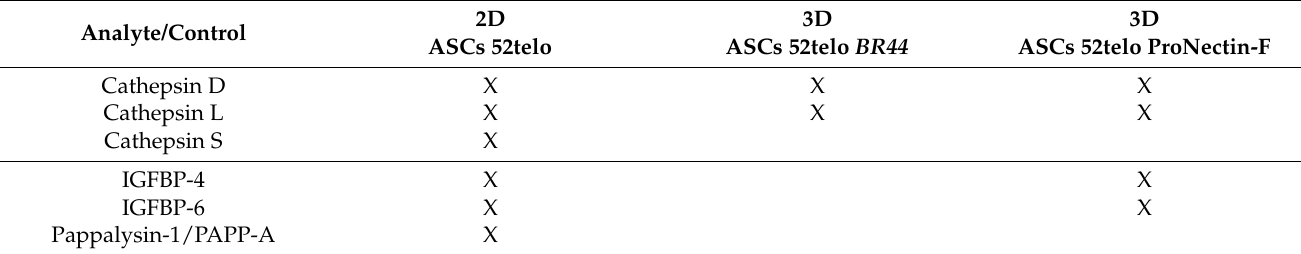
Table 5. Summary of the relevant secreted factors of ASC52telo cells cultured in standard cell culture vessels (2D) or dynamic conditions (spinner flask, 3D). In this latter case, the cells were cultured either on BR44 MC or commercial ProNectin-F (PNF) MC. Interestingly, the secretion profile of cells grown in 3D is less complex than the one obtained in the 2D condition. Moreover, when the BR44 MC is used, the number of secreted polypeptides detected is further reduced compared to PNF MC. These results suggest that the secretome of ASC52telo cells can be influenced by the cell culture conditions (2D vs. 3D) and the microcarrier type on which they grow ( BR44 vs. PNF). A less complex profile of secreted adipokines in 3D conditions may also signify that the ASC52telo better preserve their undifferentiated status when they grow on MCs in a defined dynamic system. The UrSuppe medium was used in all conditions tested for these investigations. For more details about these experiments, see Supplementary Material Figure